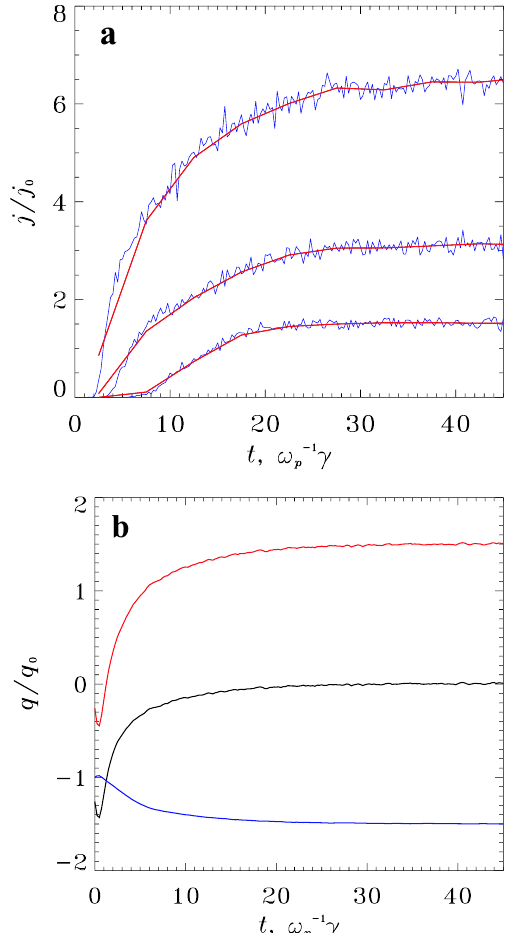
Fig. 2. ( a ) Ion current collected by spherical probe in the case ϕ =− 20 kT/e , λ D = r s = 2cm, T e = T i = T = 0 . 2 eV . The current is √ πer 2 s nV T at ϕ = 0 V . Upper, middle normalised by its value j 0 = 2 and lower curves correspond, respectively, to an H + plasma with V 0 = V Ti , V 0 = 2 V Ti and to an O + plasma with V 0 = 4 V Ti . Blue lines represent calculated values of the ion current at each itera- tion and red lines represent their averages over a period of 5 γω − 1 pe . ( b ) Variation of the total volume (red line) and surface (blue line) charges for the case V 0 = V Ti . Global charge of the system is shown in black. Charges are normalised by the surface charge in a vacuum.